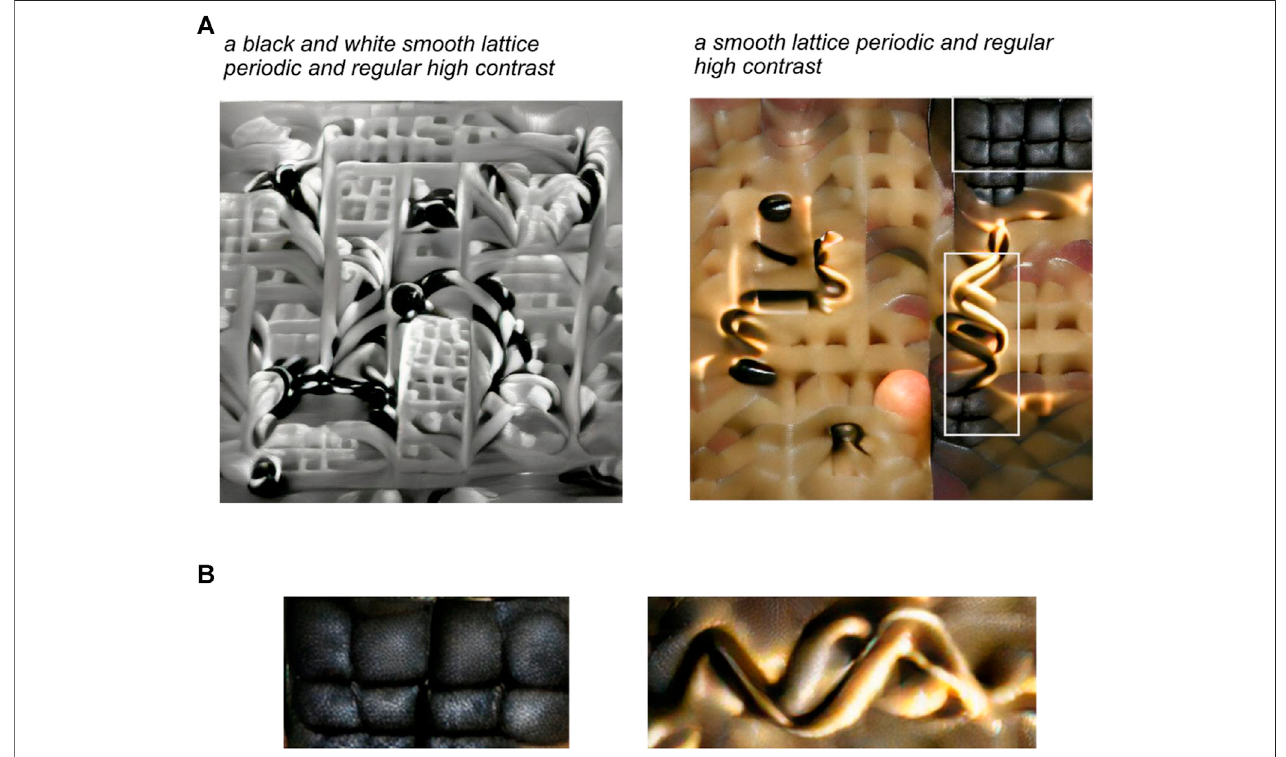
FIGURE 7 | Analysis of the effect of slight variations of input text, yielding small changes in the material design (panel A ). The lower panel B shows how the design can be used to extract small sections of the large image that show interesting material features. These can be utilized in further analysis.